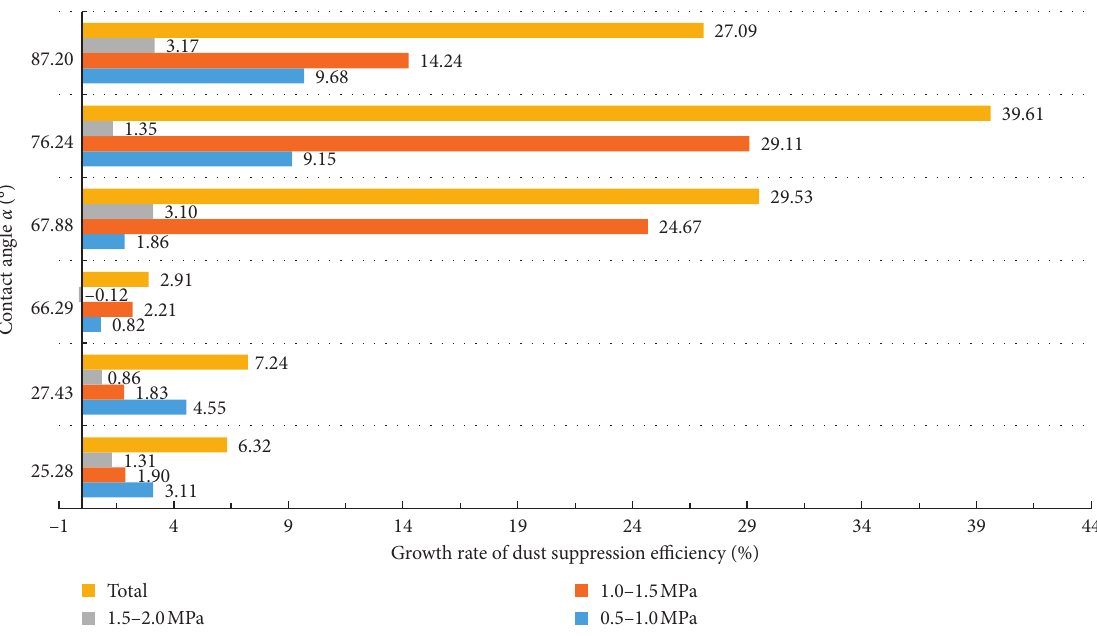
Figure 14: Relationship between dust-reduction efficiency via spraying and the contact angle of coal